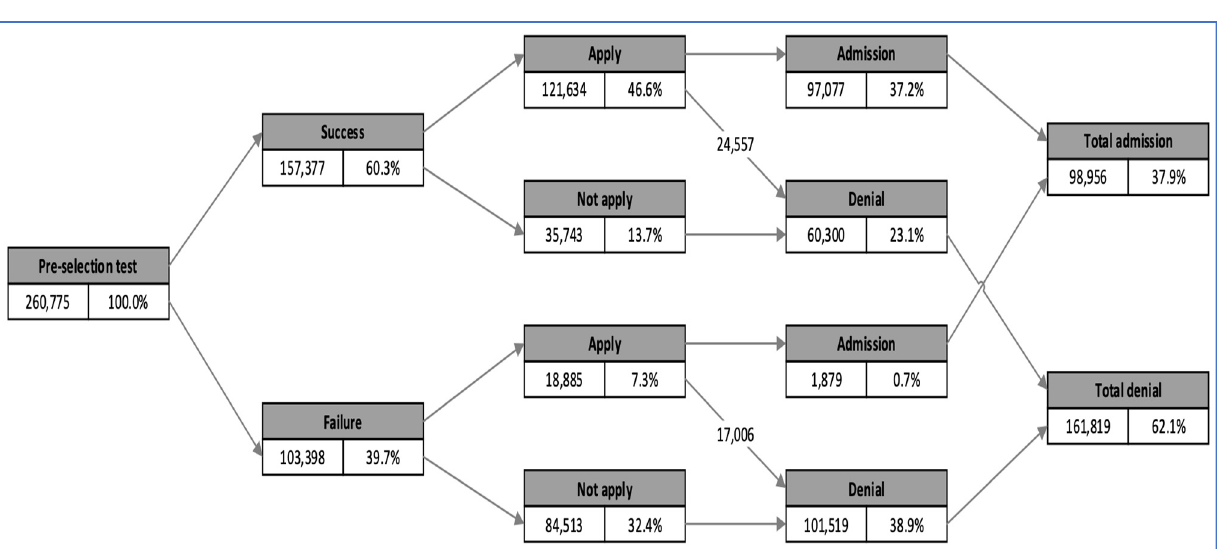
Figure 1. Trajectory data distribution.